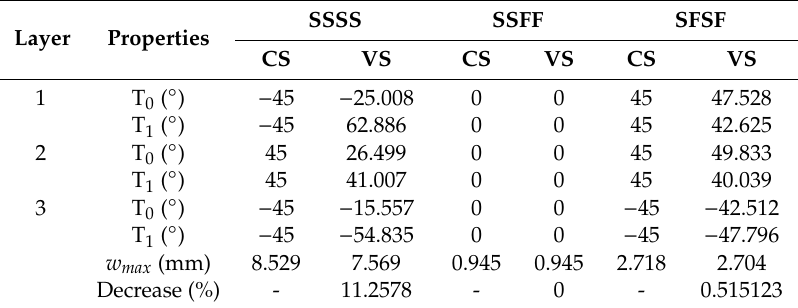
Table 17. Optimum angles for a three-layer VS plate minimum, maximum transverse deflection. SSSS, SSFF, and SFSF boundary conditions.